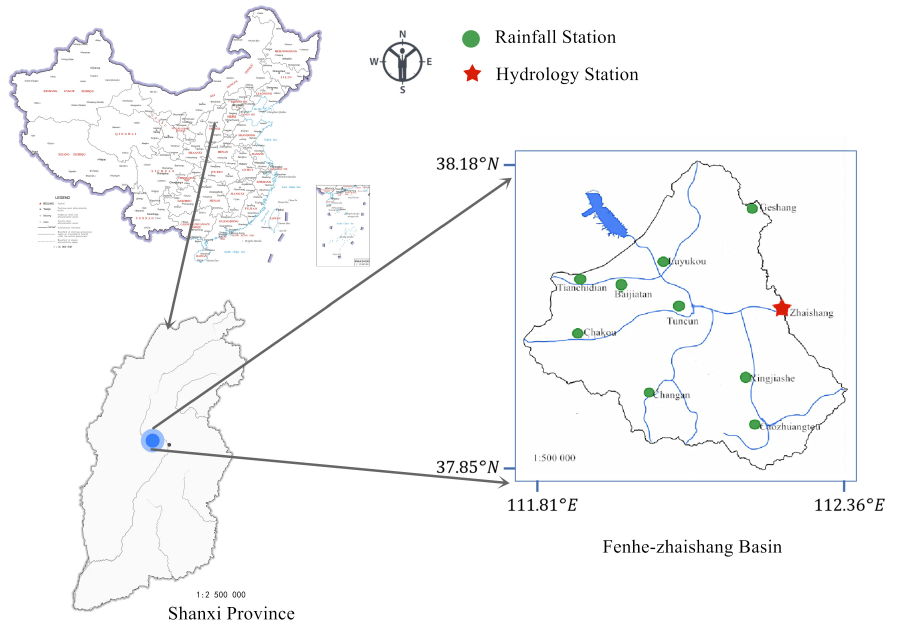
Figure 1. Map of major rainfall sites. After characteristic analysis, the above 10 rainfall stations are the main influencing factors in the flood forecast of Zhaishang. The green dot is the rainfall station, and the red dot is the forecast point of Zhaishang